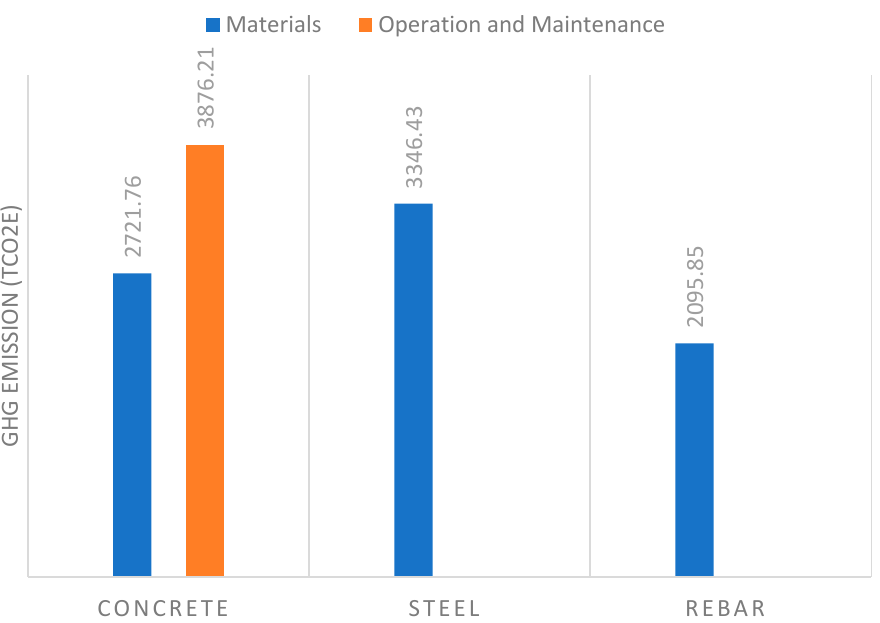
Figure 6. GHG Emissions of materials, operation and maintenance.